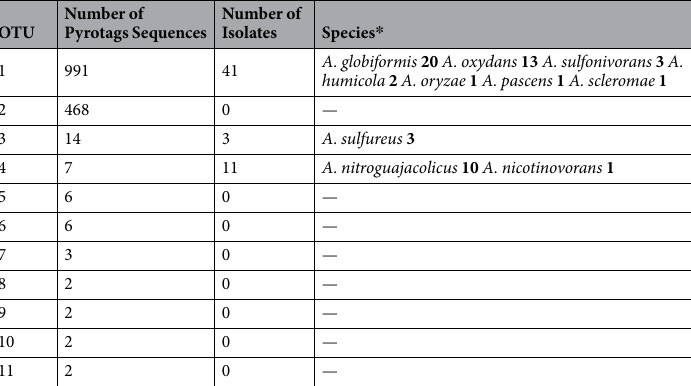
— Table 1. OTUs clustered at 100% similarity belonging to the genus Arthrobacter . Clustering was performed with aligned sequences from 16S rRNA gene region obtained by both pyrosequencing and Sanger method of isolates from rhizospheric BOF soil samples. Asterisk indicates species most closely related to the isolates according to near complete 16S rRNA gene BLASTn results, identity ≥ 99%.